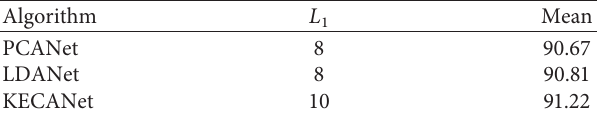
Table 4: The recognition rate of CMU Multi-PIE database.